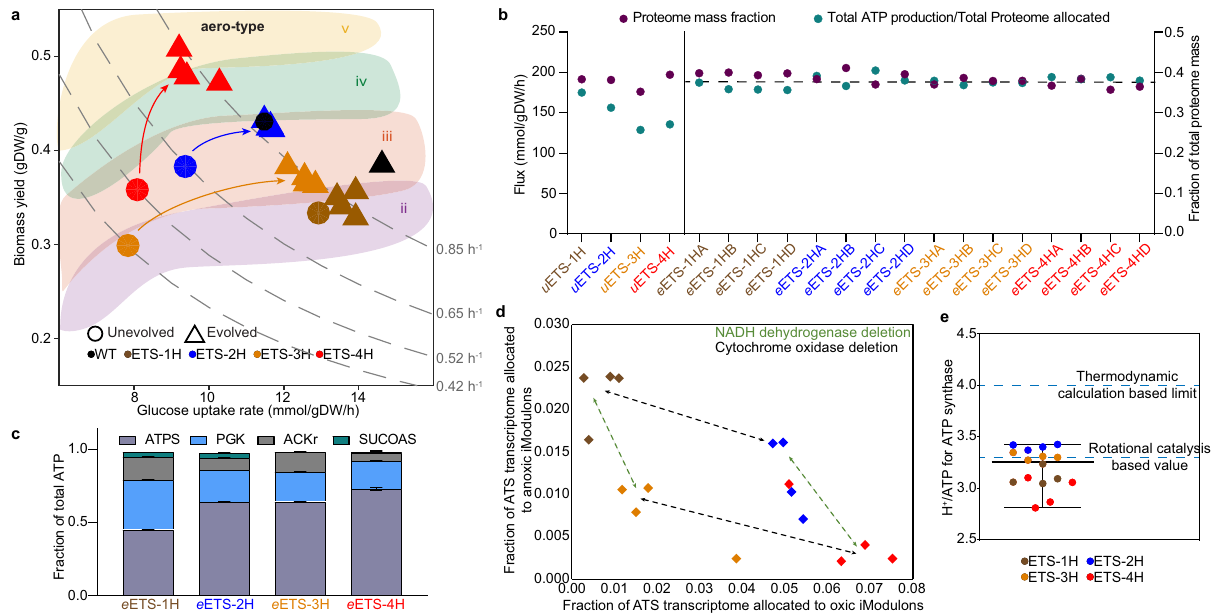
Fig. 3 Systems-level examination of ETS variants. a Aero-type classi fi cation of the ETS variants. Broken lines on the aero-type plot show growth rate isoclines. b ME-model-based examination of the ATP production (left y-axis) and proteome allocation (right y-axis) in the ETS variants. The ATP produced per ATS proteome is approximately the same. c Contributions of different ATP-producing reactions towards total ATP production. ATP production by (i) ATP synthase (ATPS) in oxidative phosphorylation, (ii) acetate kinase (ACKr) in mixed acid fermentation, (iii) succinyl-CoA synthetase (SUCOAS) in the TCA cycle, and (iv) phosphoglycerate kinase (PGK) in the glycolysis pathway is shown in the histogram. The mean and standard deviation values are calculated using four independently evolved replicates of each strain. d Tradeoffs in the expression levels of genes of iModulons associated with anoxic (y- axis) and oxic (x-axis) energetics underlie the rewiring of the ATS to allow all variants to achieve approximately the same growth rate. The lowest aerotype (ETS-1H) has high anoxic/low oxic gene expression while the highest aerotype (ETS-4) exhibits the opposite. The gene composition of the iModulons is shown in Supplementary Table 4. The outliers of the replicates for an ETS variant are re fl ections of the differences in their genotypes (Supplementary Fig. 2, Supplementary Data 1). e Estimation of the number of protons required for the phosphorylation of ADP by ATP synthase (proton-to-ATP ratio) using the ME-model and the experimental data. Individual values of four independently evolved replicates of each ETS variant have been shown on the plot and corresponding median and range of values have been presented. Source Data available in Supplementary Table 3 and provided RNA-seq